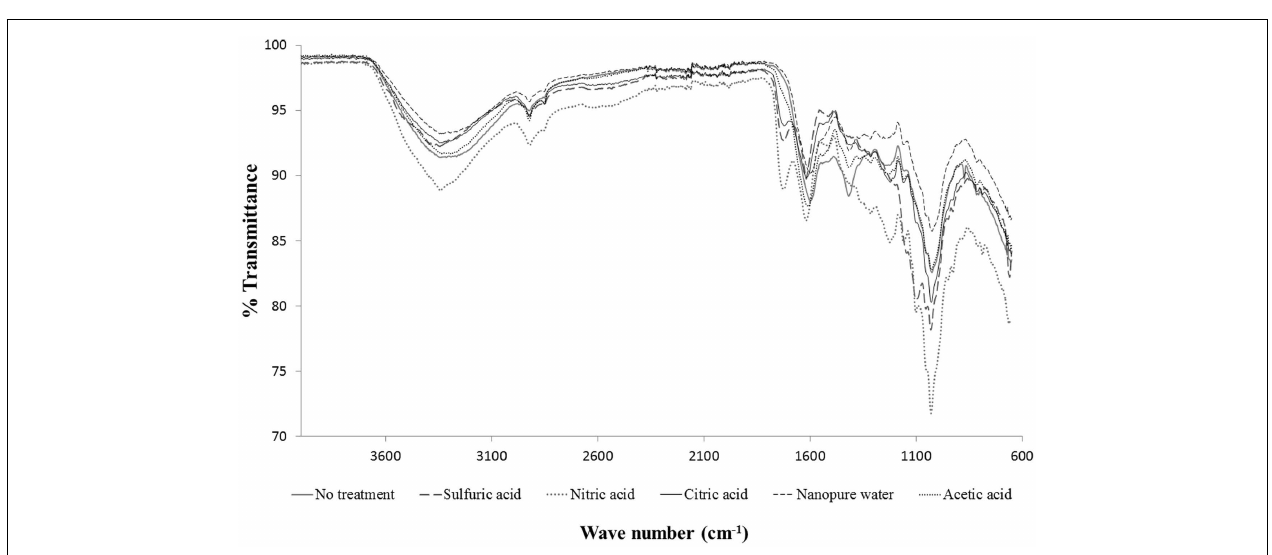
FIGURE 2 | Fourier transform infrared spectra of Sargassum biomasses after demineralization processes .